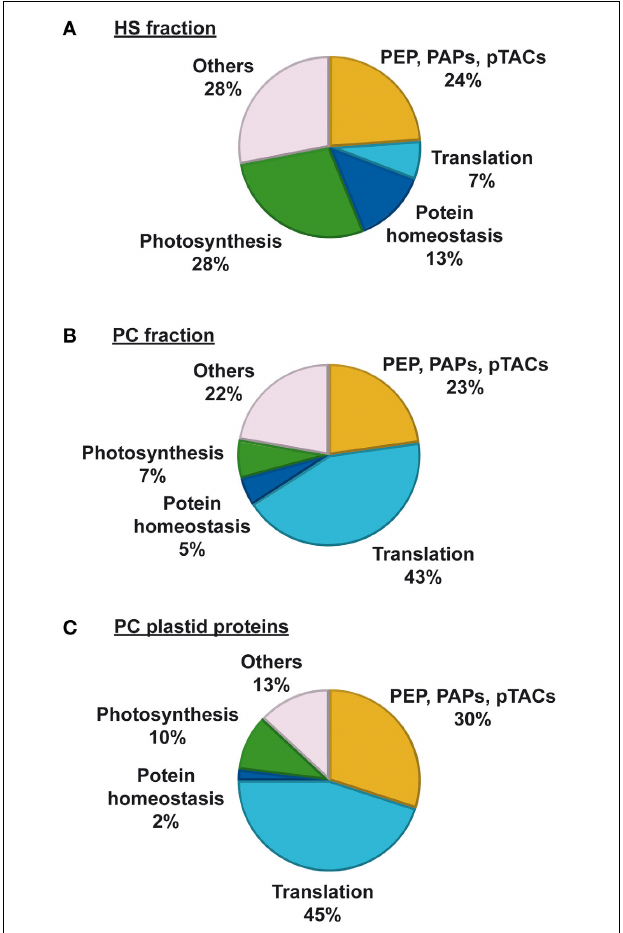
FIGURE 3 | Overview and comparison of the protein content in HS and PC fractions. (A) Distribution of the identified proteins of the HS fractions analyzed in Schröter et al. (2010) and classification into groups in correlation to the recent work. (B) Percentage of identified proteins of PC peak fractions analyzed in this work and classified into groups as shown in Table 1 . (C) Distribution of solely the plastid proteins of the recent PC fractions to functional groups according to Table 1 but with an aggregation of “PEPs and PAPs” with “Other pTACs” and a part of “DNA and RNA” to one bin